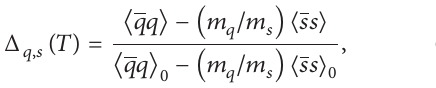
PLSM (solid curve), QLSM (dotted curve), PNJL (double- dotted curve), and HRG (dash-double-dotted curve) in Figure